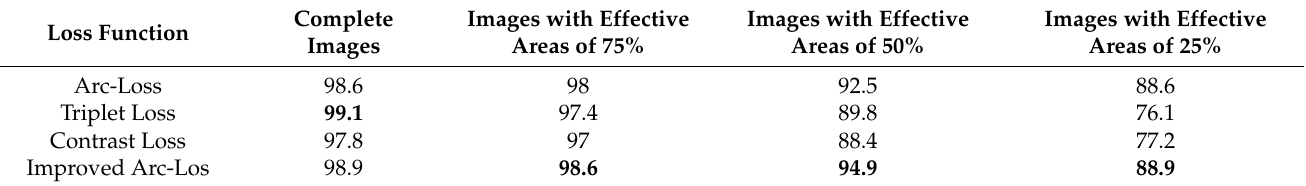
Table 1. The identification rate of the network trained with different loss functions (Rank-20). The best results are marked in